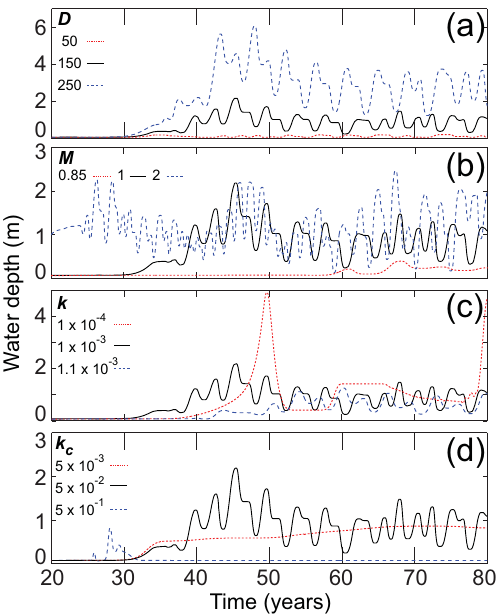
Figure 8. Maximum lake depth in the overdeepening from sensi- tivity testing. In each plot the black (solid) curve is the standard output. Tests of (a) overdeepening depth, D (m), (b) water in- put into the distributed system, M (mma − 1 ), (c) distributed sys- tem conductivity k (m 7 / 4 kg − 1 / 2 ) and, (d) channel conductivity, k c (m 3 / 2 kg − 1 / 2